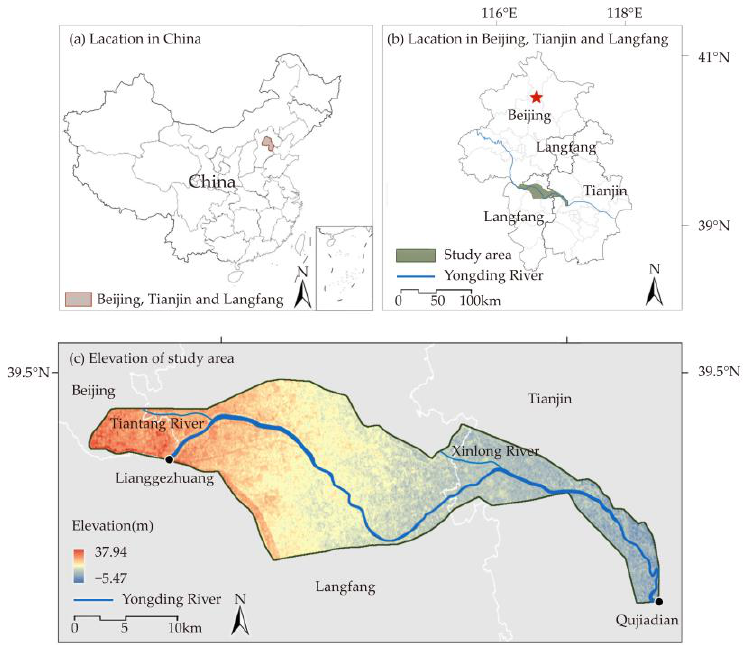
Figure 1. Geographic location of the study area.